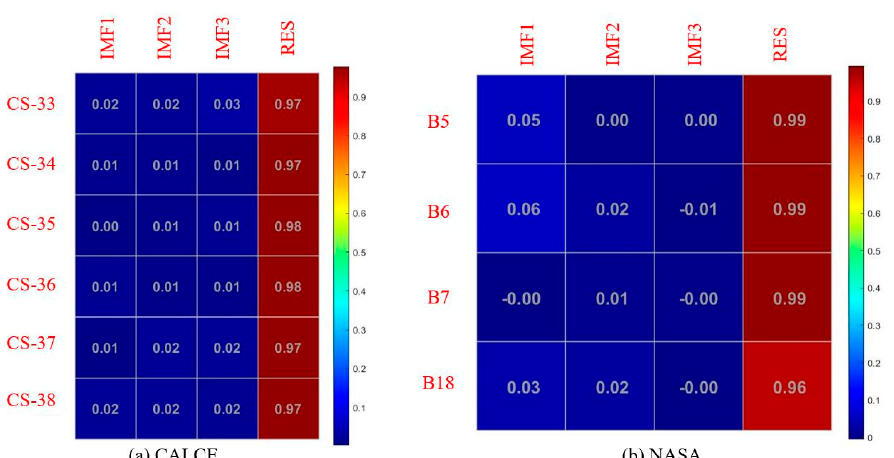
Figure 7. Spearman correlation coefficient between IMFs, RES, and original capacity.